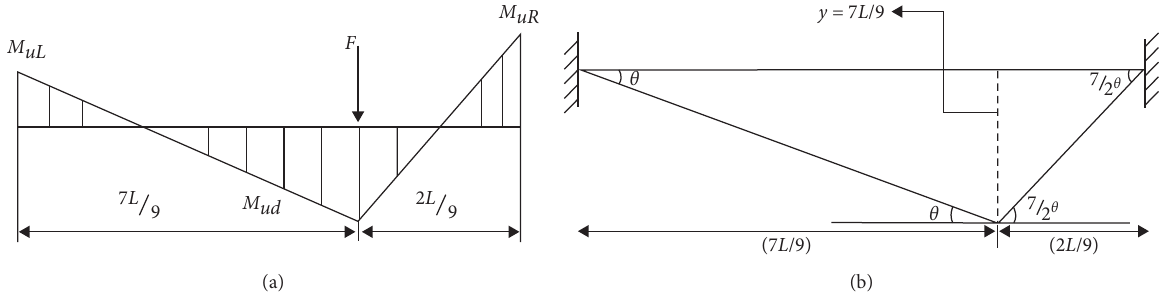
Figure 11: The specimen subjected to (a) a concentrated load at the ( 2/9 ) L of span and (b) plastic